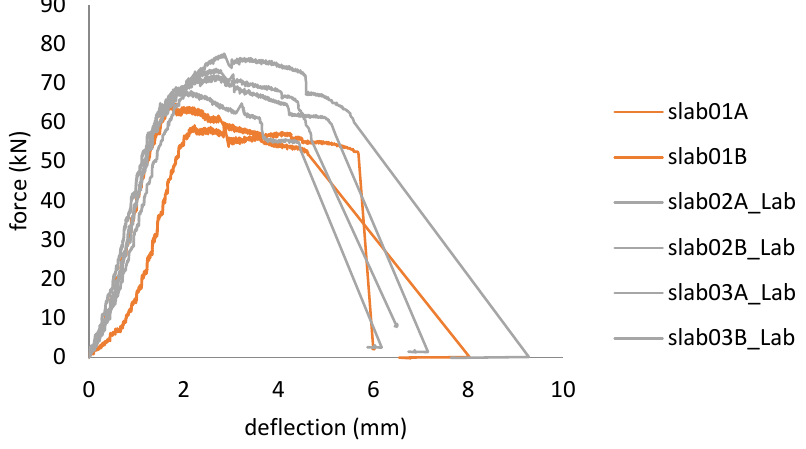
Figure 13. Load-deflection curves (_Lab: cast in the laboratory).